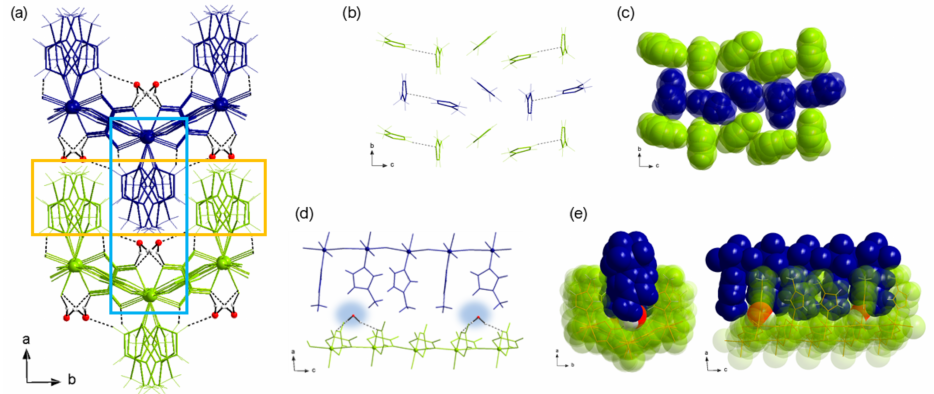
Figure 2. ( a ) Projection of a fragment of the crystal packing of 1 along the crystallographic c axis, showing two interdigitated layers in different colors. N-H · · · Ow, N-H · · · O ox and Ow · · · O ox type H-bonds are depicted as dashed lines. ( b ) Projection of the hydrophobic interlayer region [orange box in (a)] along the crystallographic a axis, with the weak inter-pyrazole intralayer N-H · · · N H-bond in evidence. ( c ) Same as ( b ), space-filling representation. ( d ) Detailed side view of a fragment of the interlayer region [sky blue box in ( a )] showing the existence of very small hydrophobic cavities arising from the peculiar relative orientation of the three crystallographically independent 4-Hmpz moieties in 1 . ( e ) Another zoomed-in view of the interlayer region along the crystallographic c (left) and b (right) axes, evidencing the well-defined position of the water molecules of crystallization; space-filling